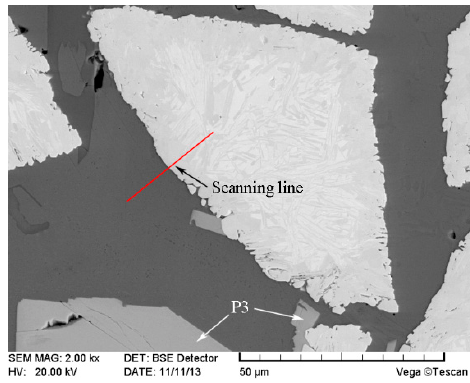
Figure 8. SEM image of the modified CTC P -NiCrBSi.